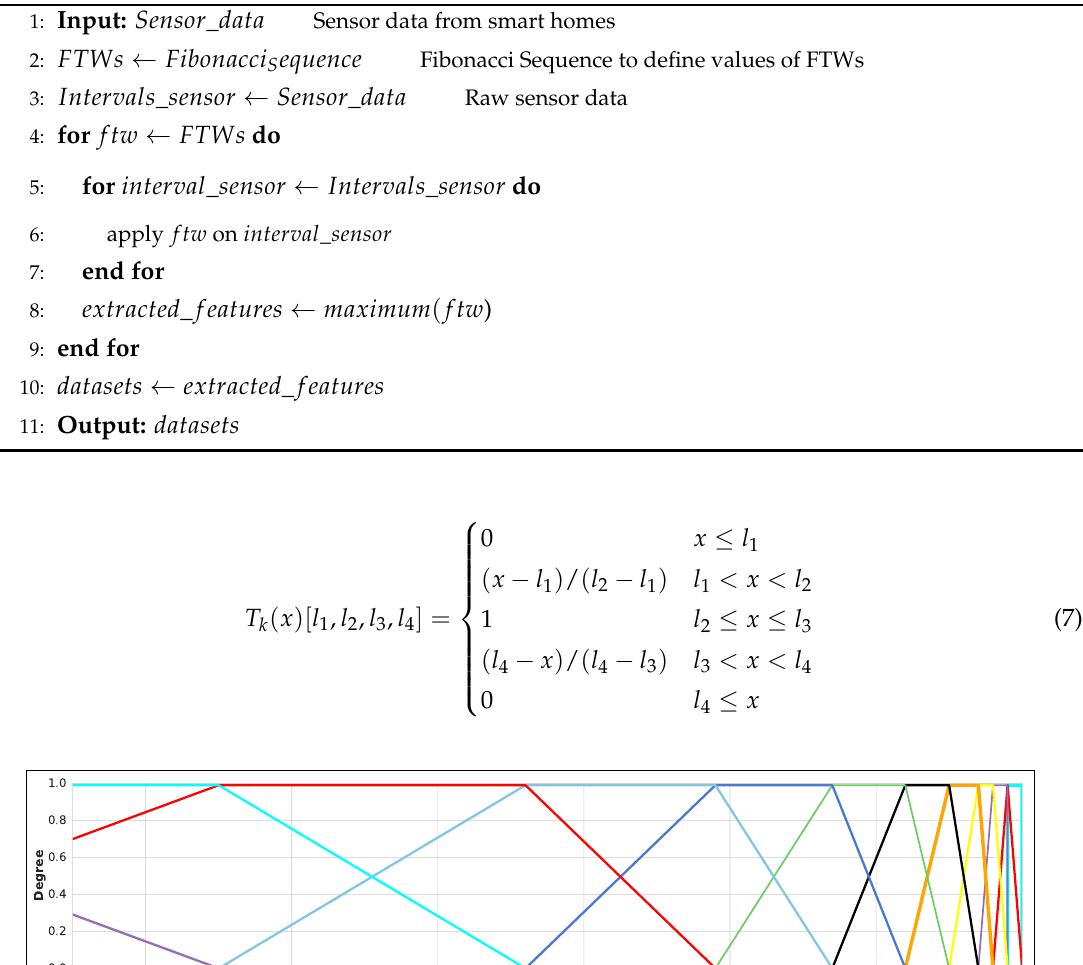
Algorithm 1: Fuzzy temporal windows to generate input Datasets